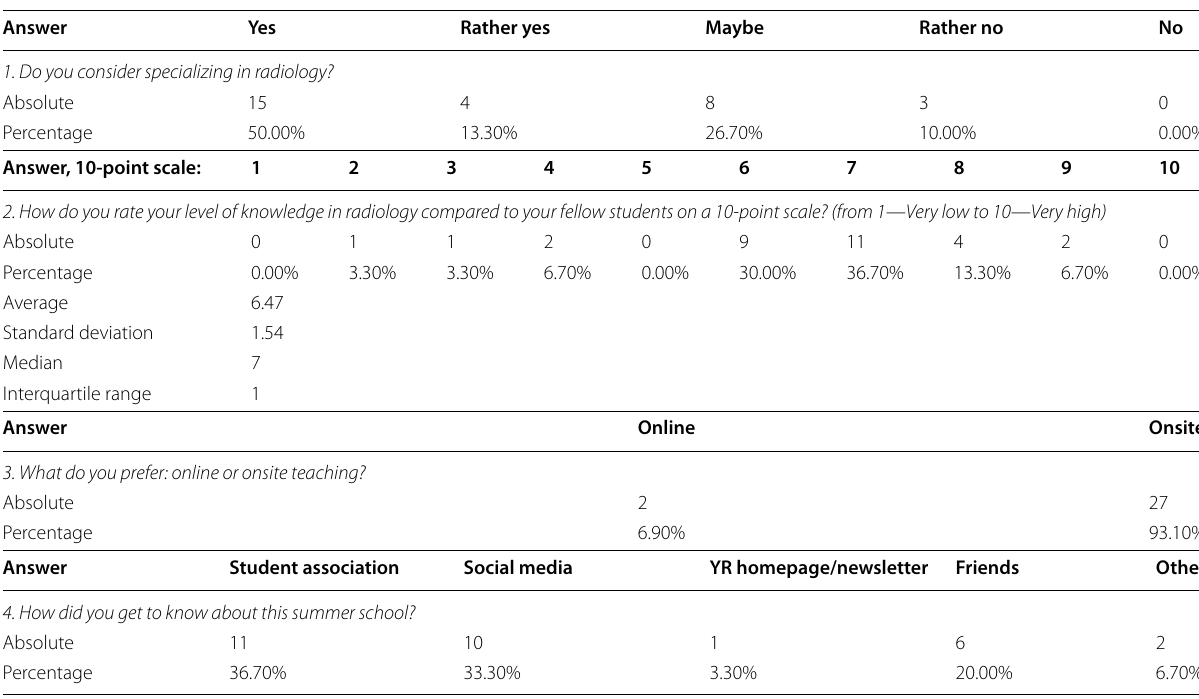
Table 2 Results of the Questionnaire Day